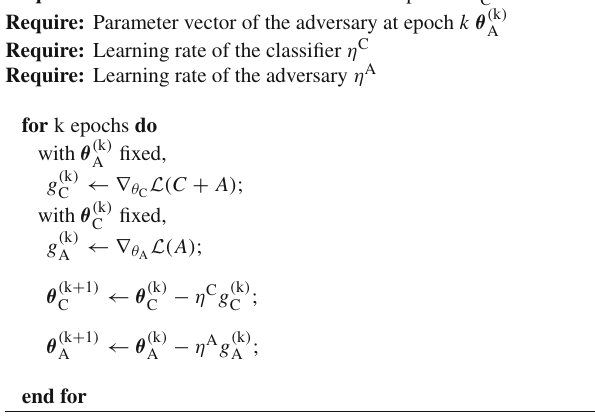
Algorithm 1 Two-step training of the